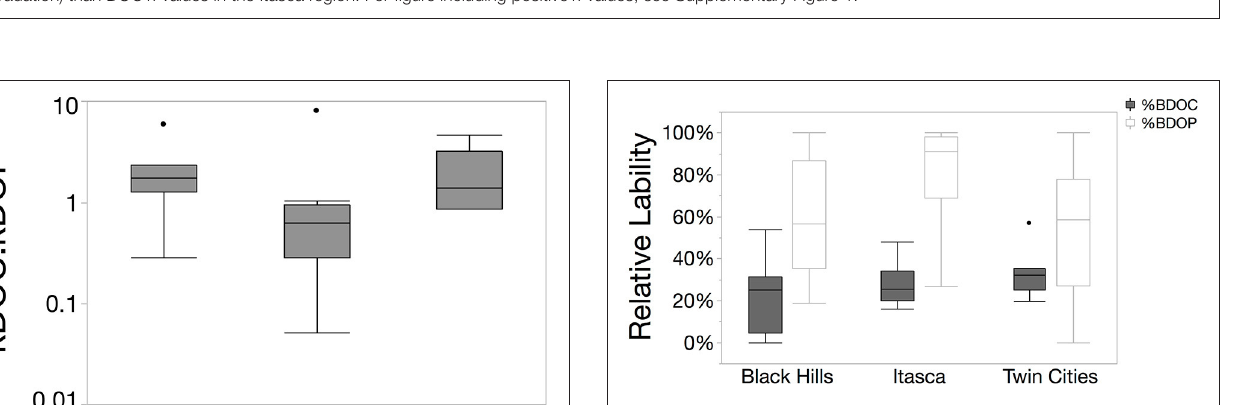
FIGURE 3 | Box and whisker plots of DOC and DOP degradation constants (k) from exponential decay models. Only lakes that had negative k values are included in this figure. In the Black Hills and Twin Cities regions, k values are very similar for DOC and DOP. However, DOP k values are more negative (meaning faster degradation) than DOC k values in the Itasca region. For figure including positive k values, see Supplementary Figure 1.